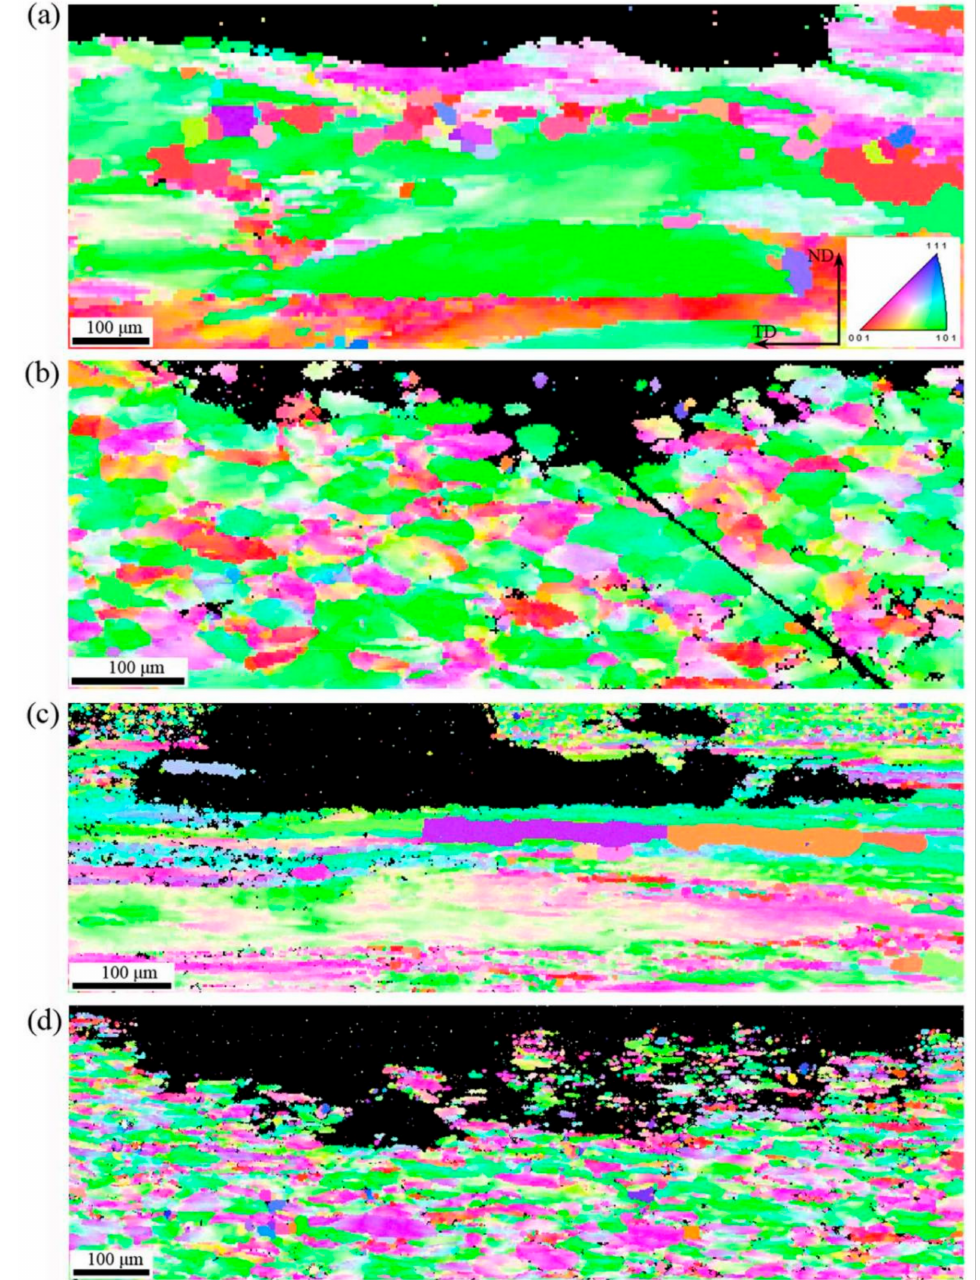
Figure 9. Grain orientation maps of IGC samples in the transverse section. ( a ) Al-Zn-Mg-Cu-Zr alloy in the central layer, ( b ) Al-Zn-Mg-Cu-Sc-Zr in the central layer, ( c ) Al-Zn-Mg-Cu-Zr alloy in the surface layer, ( d ) Al-Zn-Mg-Cu-Sc-Zr alloy in the surface